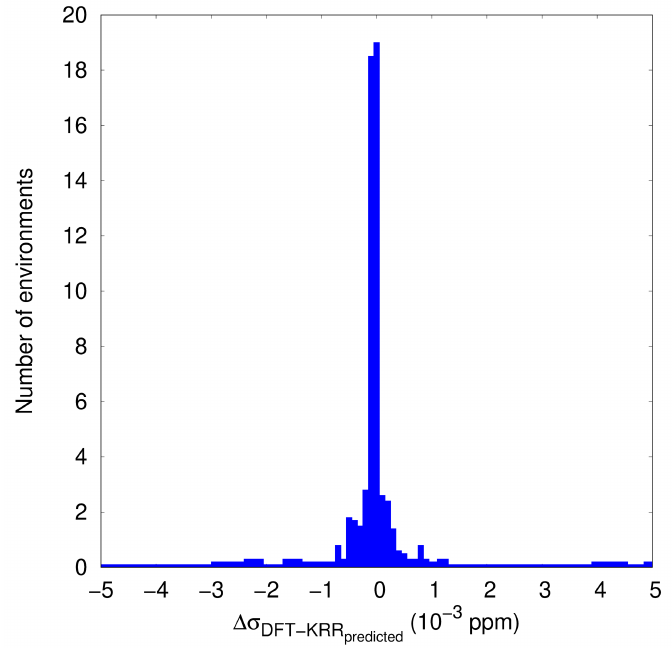
Figure 5. Distribution of the differences between the isotropic shielding values computed with DFT and those predicted with the ML-KRR method. Only silicon atomic environments are con- sidered. The histograms are obtained with an interval of 0.1 ppm in the count of the number of atomic